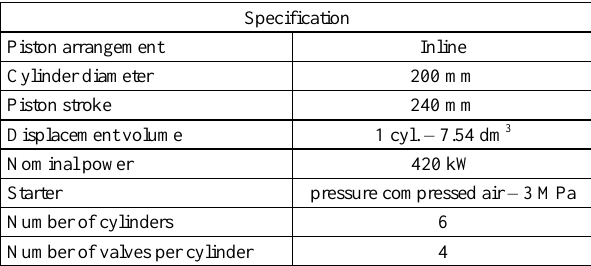
Table 2. Marine diesel engine Sulzer type